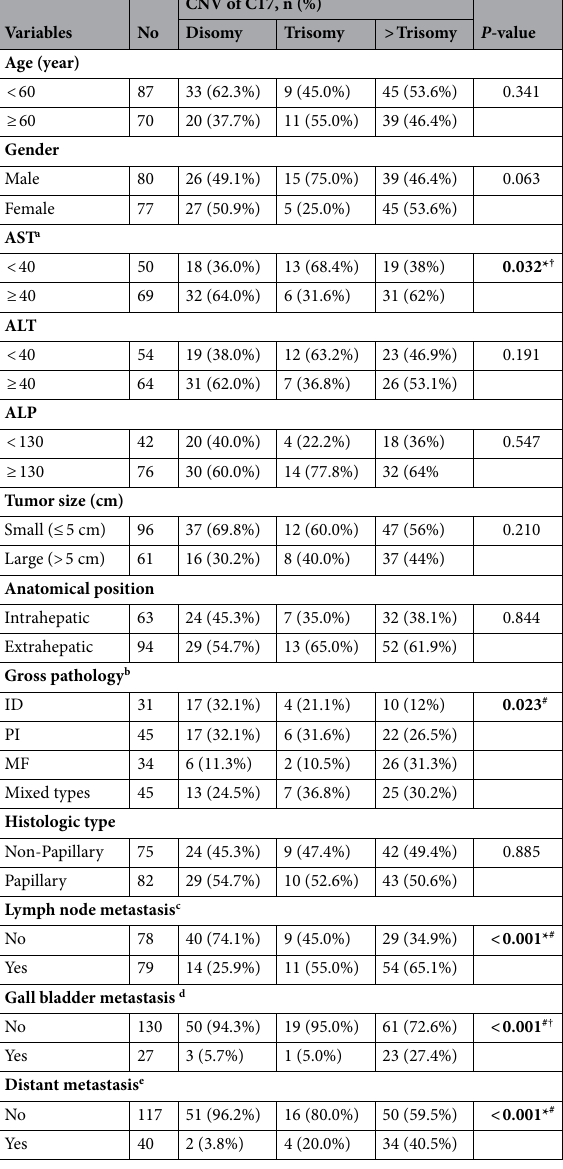
Table 2. The correlation of C17 CNVs with clinicopathological features of CCA patients. *P < 0.05 Disomy vs Trisomy; # P < 0.05 Disomy vs > Trisomy; † P < 0.05 Trisomy vs > Trisomy. a AST Disomy vs Trisomy; P = 0.016, Trisomy vs > Trisomy;P = 0.019. b Gross Pathology: Disomy vs > Trisomy; P = 0.006. c Lymnode Metastasis: Disomy vs Trisomy; P = 0.019;Disomy vs > Trisomy; P < 0.001. d Gall bladder Metastasis: Disomy vs > Trisomy; P = 0.002, Trisomy vs > Trisomy y; P = 0.040. e Distant Metastasis: Disomy vs Trisomy; P = 0.023, Disomy vs > Trisomy; P =